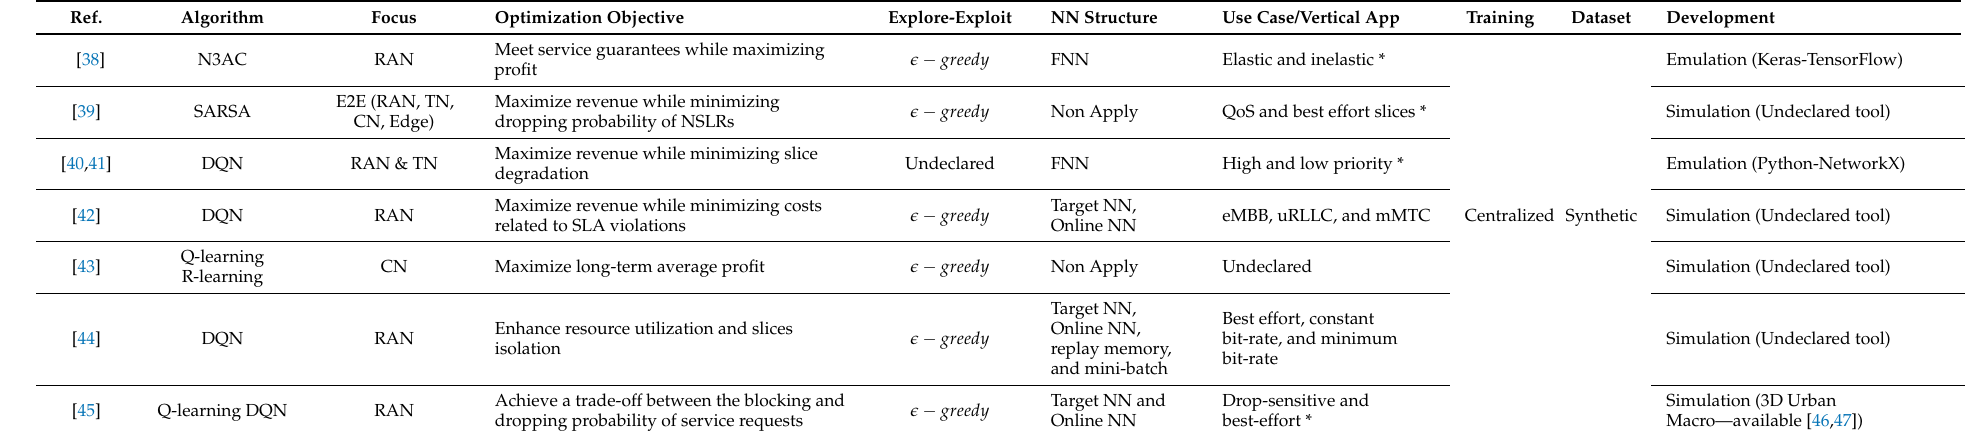
Table 1. Admission control based on RL and DRL.